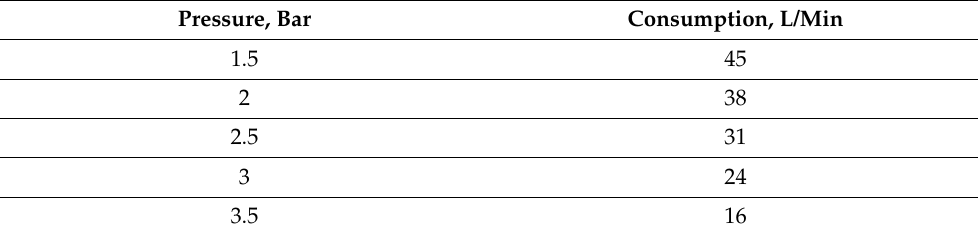
Table 1. Dependence of pump performance on discharge pressure.